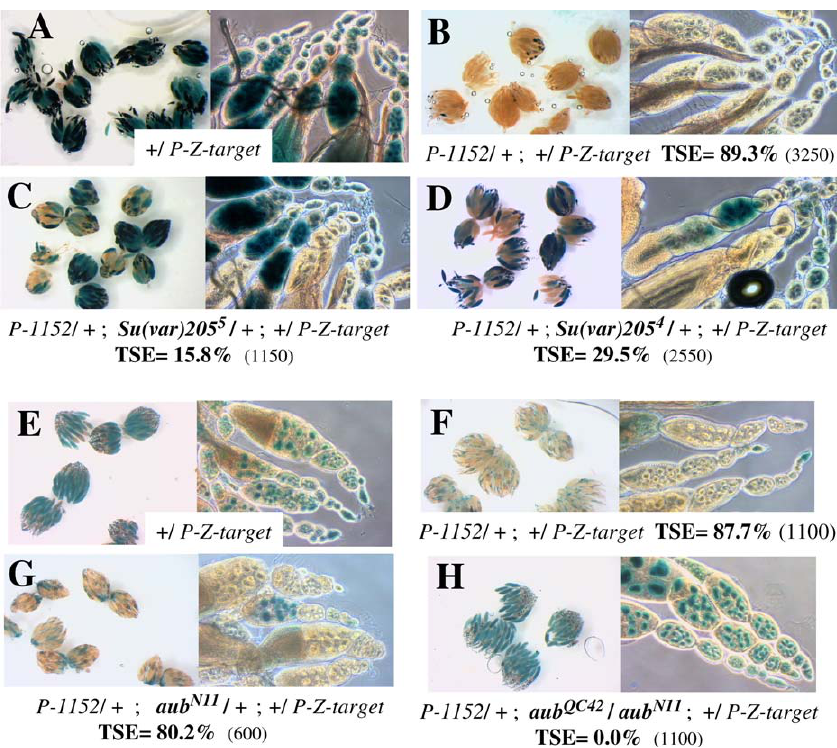
Figure 4. TSE Is Sensitive to Mutations in Genes Involved in Heterochromatin Formation and RNA Silencing In each case, the percentage of TSE is given with the total number of egg chambers counted in parentheses. Females analyzed carried a maternally inherited P-1152 telomeric silencer locus (from a homozygous P-1152 mother). (A–D) Mutations affecting HP1. (A) Expression control of the P-otu-lacZ transgene ( P-Co1 ) used as TSE target. (B) G 1 females produced by the cross between P-1152 females and P-Co1 males. (C, D) Females having paternally inherited the P-Co1 target and maternally inherited the P-1152 telomeric silencer locus together with a Su(var)205 mutant allele. (E–H) Mutations affecting AUBERGINE. (E) Expression control of the BQ16 target transgene. (F–H) These three types of females have maternally inherited a P-1152 telomeric silencer and paternally inherited the BQ16 target: (F) TSE positive control ( aub þ / aub þ ); (G) one maternally inherited mutant aub allele; (H) loss of function of aub in a heteroallelic mutant